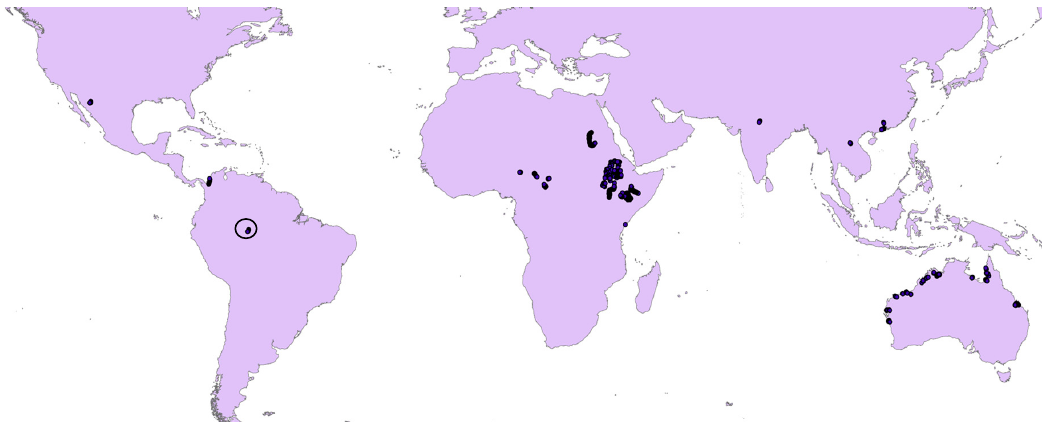
Figure 2. Distribution of the collected global river dataset (the black circle located in the Northern part of South America will be further visualized in Figure 3).